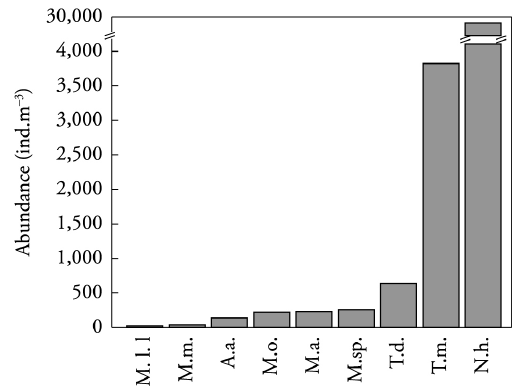
Figure 3. Copepod abundance in the studied period.